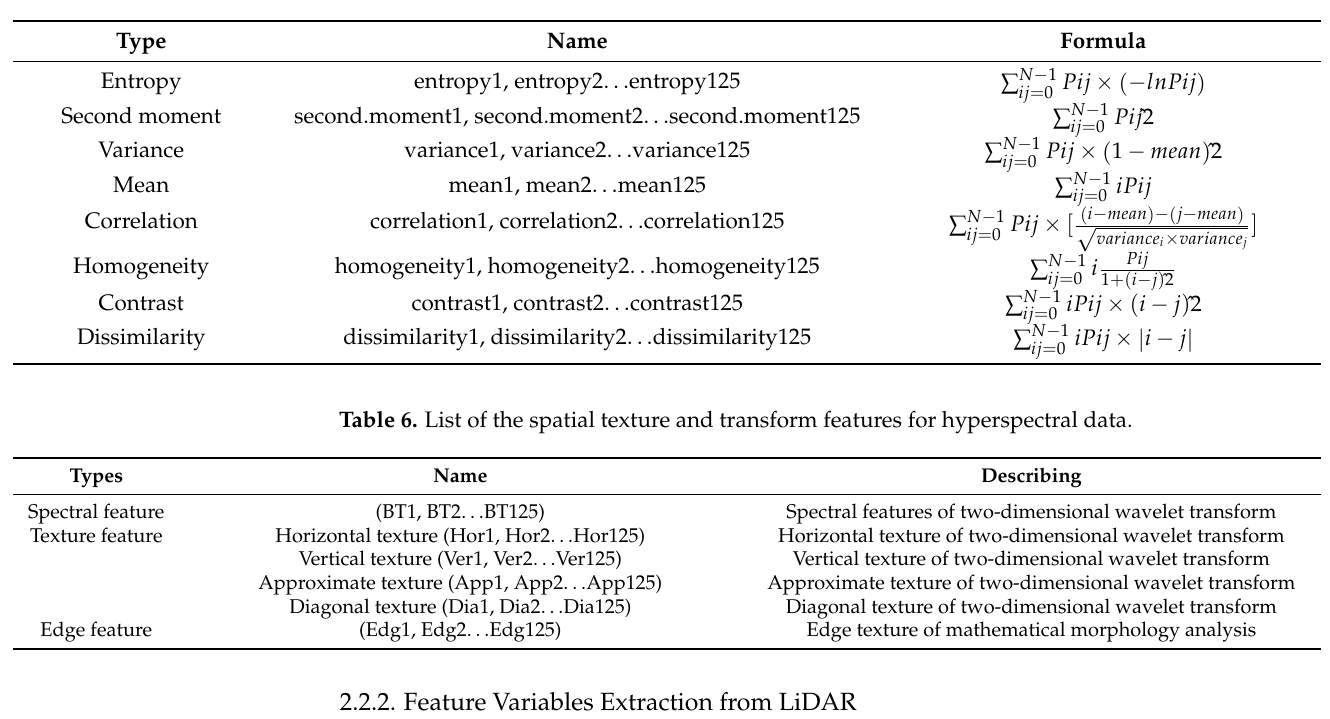
Table 5. List of the second-order texture indices calculated by GLCM for hyperspectral data.